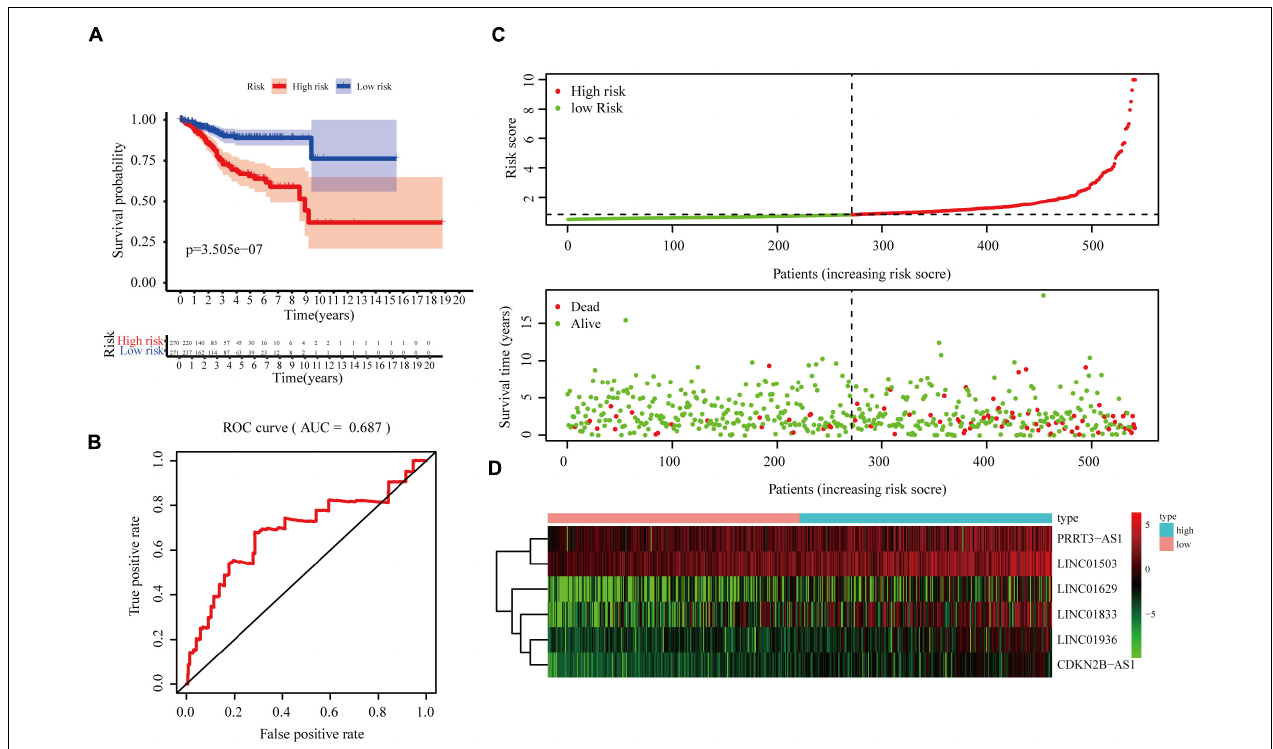
FIGURE 3 | Correlation between the six immune-related lncRNA signature and the OS and prognosis of patients with EC. (A) Kaplan–Meier OS curves for the high- and low-risk groups. (B) Risk curve of each sample reordered by risk score. (C) Scatter plot of OS. Green and red dots represent survival and death, respectively. (D) Heatmap showing the expression profiles of the signature in the low- and high-risk groups. The pink and blue bars represent the low-and high-risk groups, respectively.